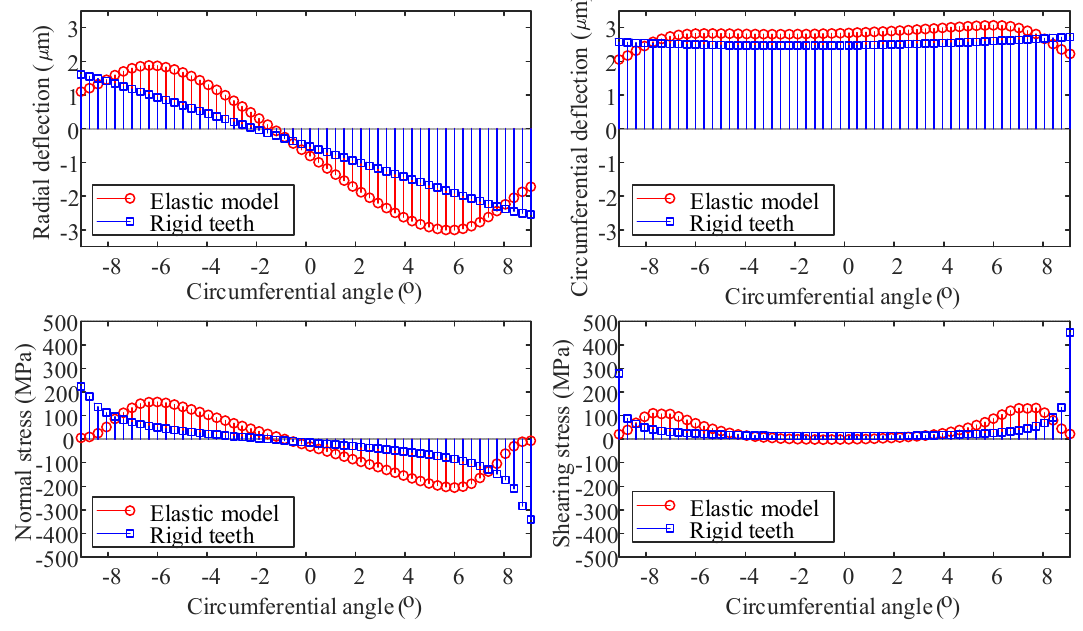
Figure 5. Deformation and stress along tooth root.